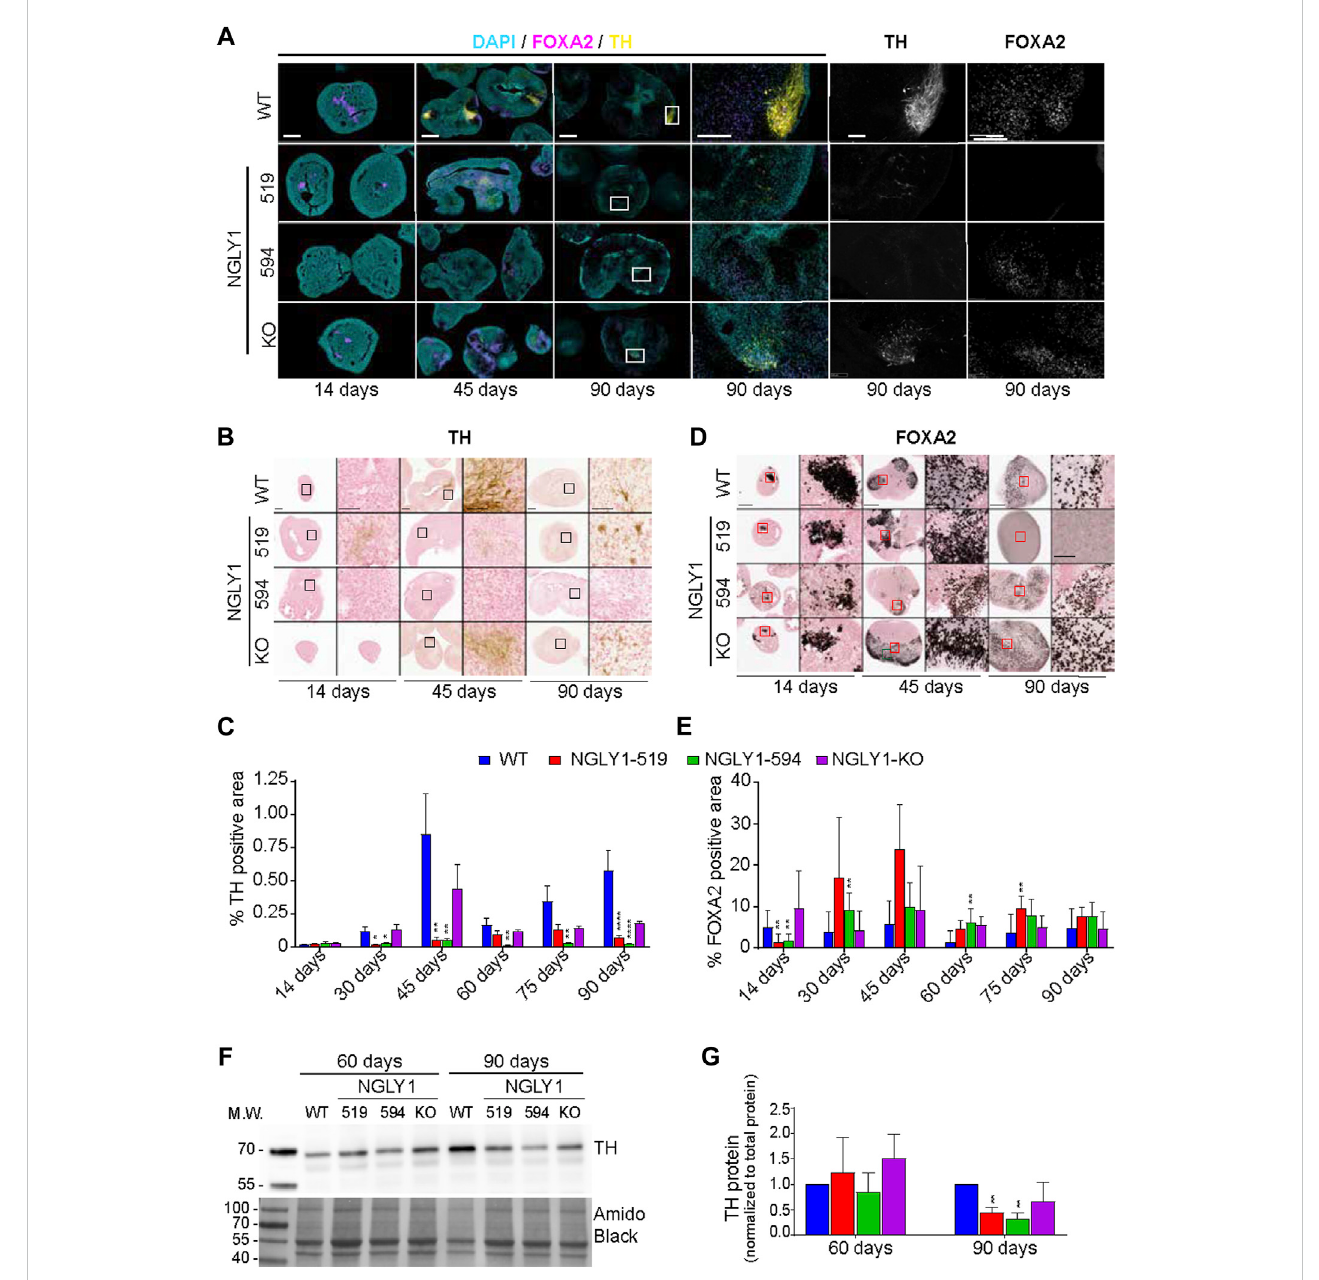
FIGURE 3 Expression of neuronal markers tyrosine hydroxylase (TH) and FOXA2 in midbrain organoids. (A) Representative immuno fl uorescence images at×5 and×20 magni fi cation showingDAPI(cyan), FOXA2 (magenta) and TH(yellow). Scalebars:250um(5x) and 50um(20x),white boxes indicatezoomedin region. (B) Representative bright fi eld images of TH immunohistochemistry staining at ×4 and ×20 magni fi cation. Scale bars: 250um (4x) and 50um (20x), black boxes indicate zoomed in region. (C) Quanti fi cation of total percent positive TH staining. (D) Representative bright fi eld images of FOXA2 immunohistochemistry staining at ×4 and ×20 magni fi cation. Scale bars: 250um (4x) and 50um (20x), red boxes indicate zoomed in region. (E) Quanti fi cation of total percent positive FOXA2 staining. (F) A representative western blot showing TH expression in cell lysates obtained from control and NGLY1diseasemidbrainorganoids. (G) Quanti fi cationofTHproteinexpressionnormalizedtototalprotein.Datarepresentativeofallslicesderivedfromthree midbrainorganoids.Statisticalsigni fi cancedeterminedbymultiple t -testanalysisdenotedby*=( p ≤ 0.05),**=( p ≤ 0.01),***=( p ≤ 0.001),****=( p ≤